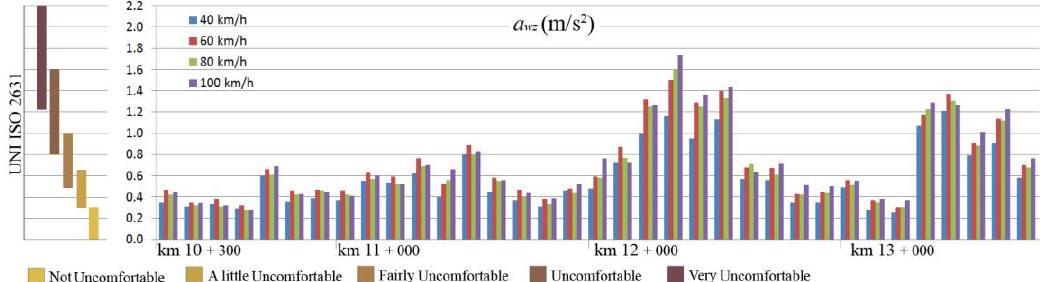
Figure 10. Vertical weighted root mean square (RMS) acceleration ( a wz ).